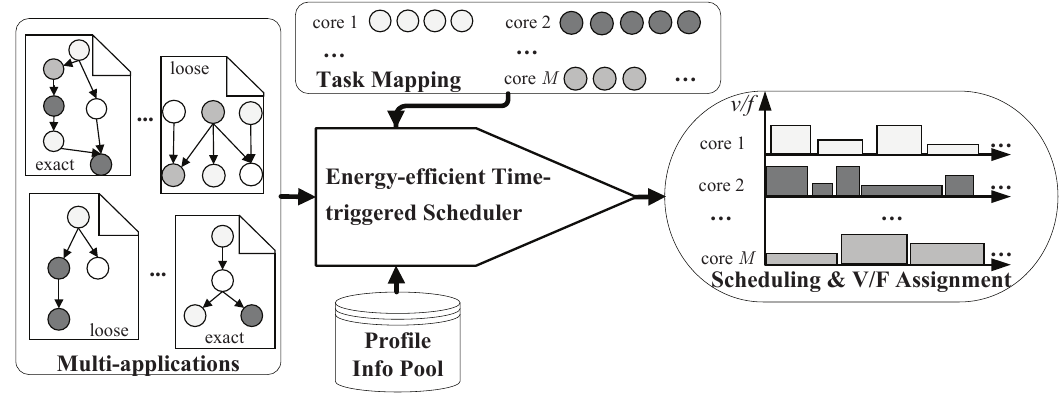
Figure 3. Energy-efficient time-triggered scheduling problem for strict and non-strict periodic